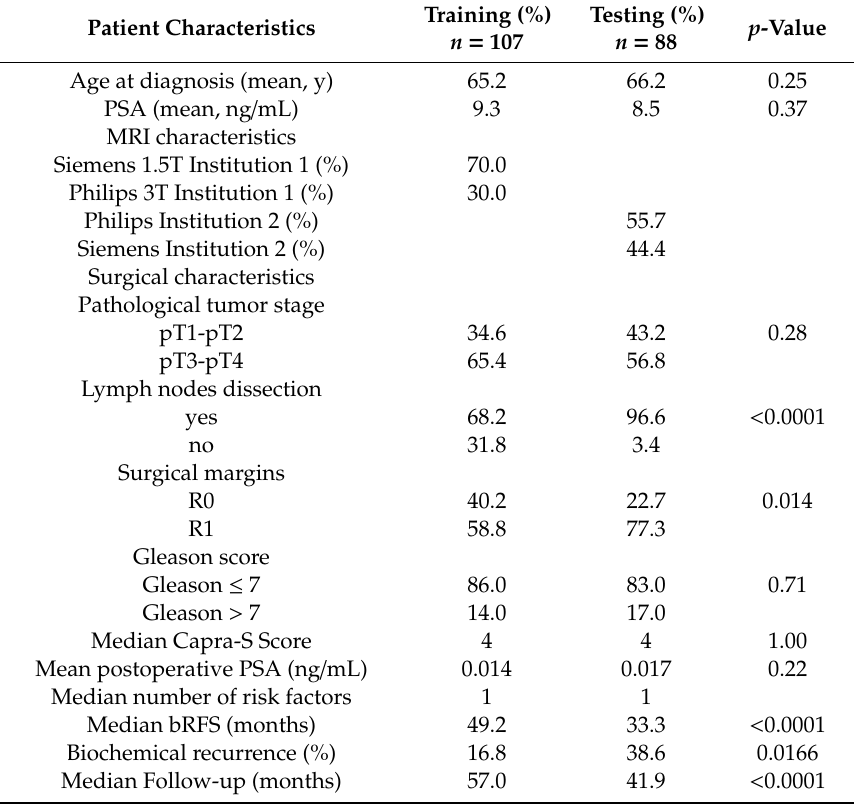
Table 1. Patient and tumor characteristics in training and testing